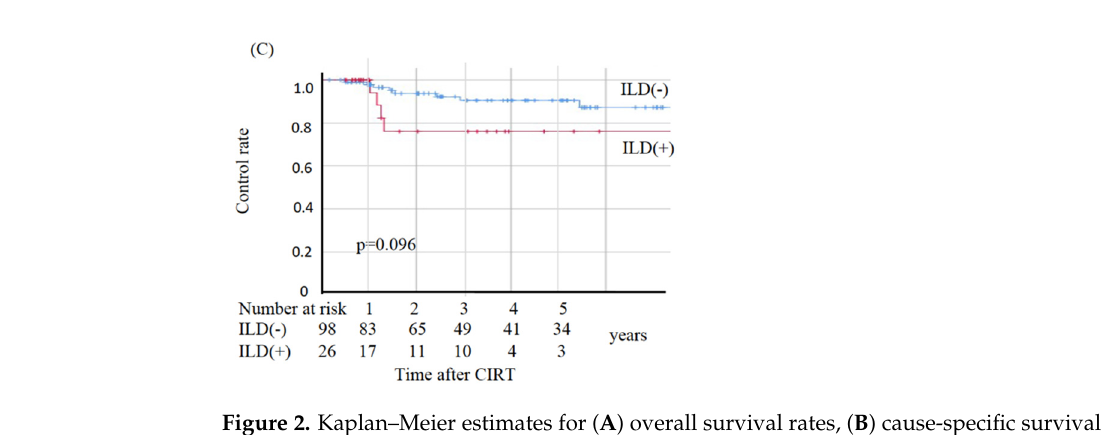
Figure 2. Kaplan–Meier estimates for ( A ) overall survival rates, ( B ) cause-specific survival rates, and ( C ) local control rates. Blue lines: non-ILD group ( n = 98), red lines: ILD group ( n = 26).